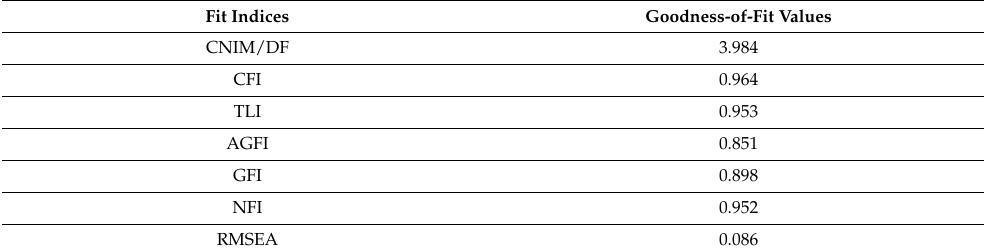
Table 3. Model goodness of fit.